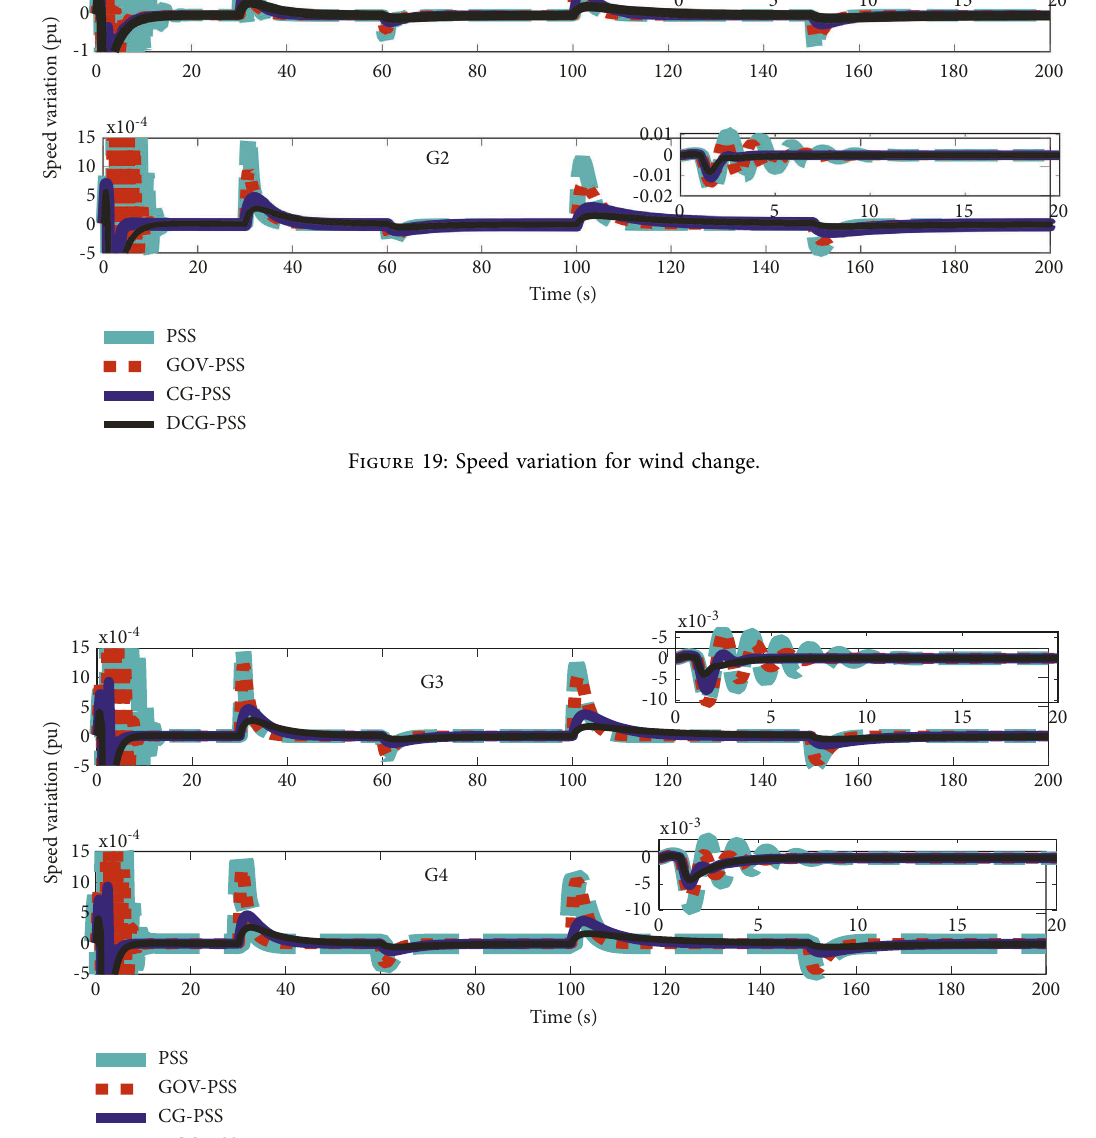
Figure 20: Speed variation for wind